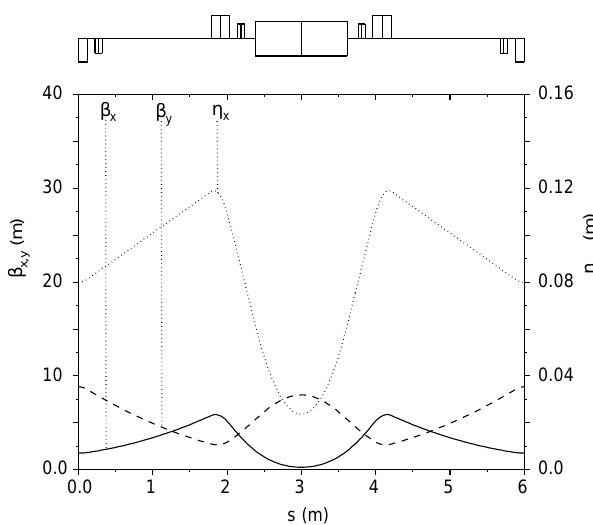
FIG. 5. Optical functions of a three-quad TME cell for the NLC MDR with separated function magnets. Magnet layout is indicated at the top with the bend in the center and quadrupoles shown larger than sextupoles.